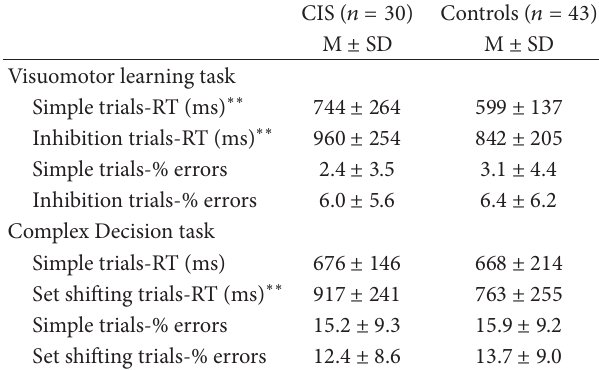
Table 2: Descriptive statistics for motor-executive task perfor-